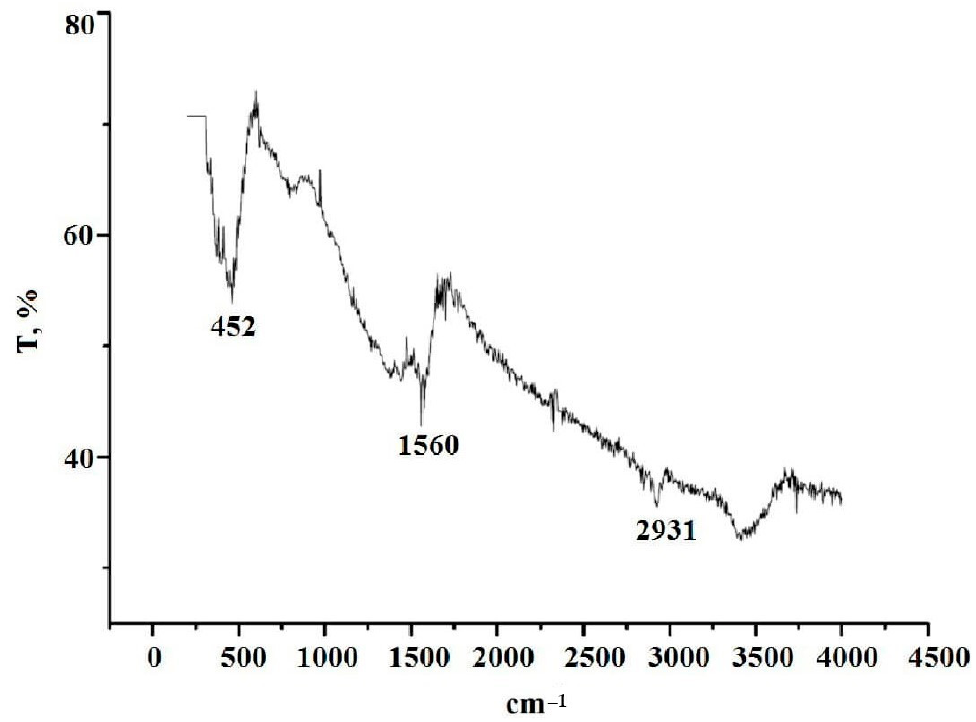
Figure 8. IR spectrum of the product of solid-state thermolysis of silver maleate.